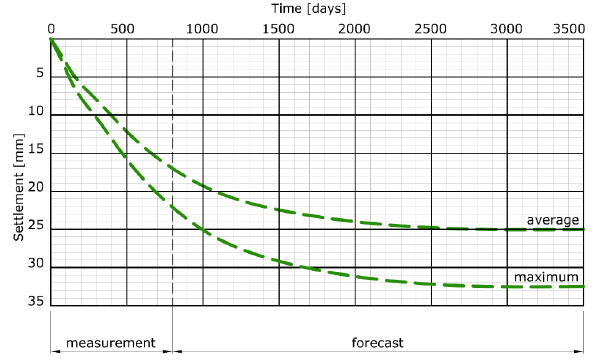
Figure 7: Forecast final settlement of the